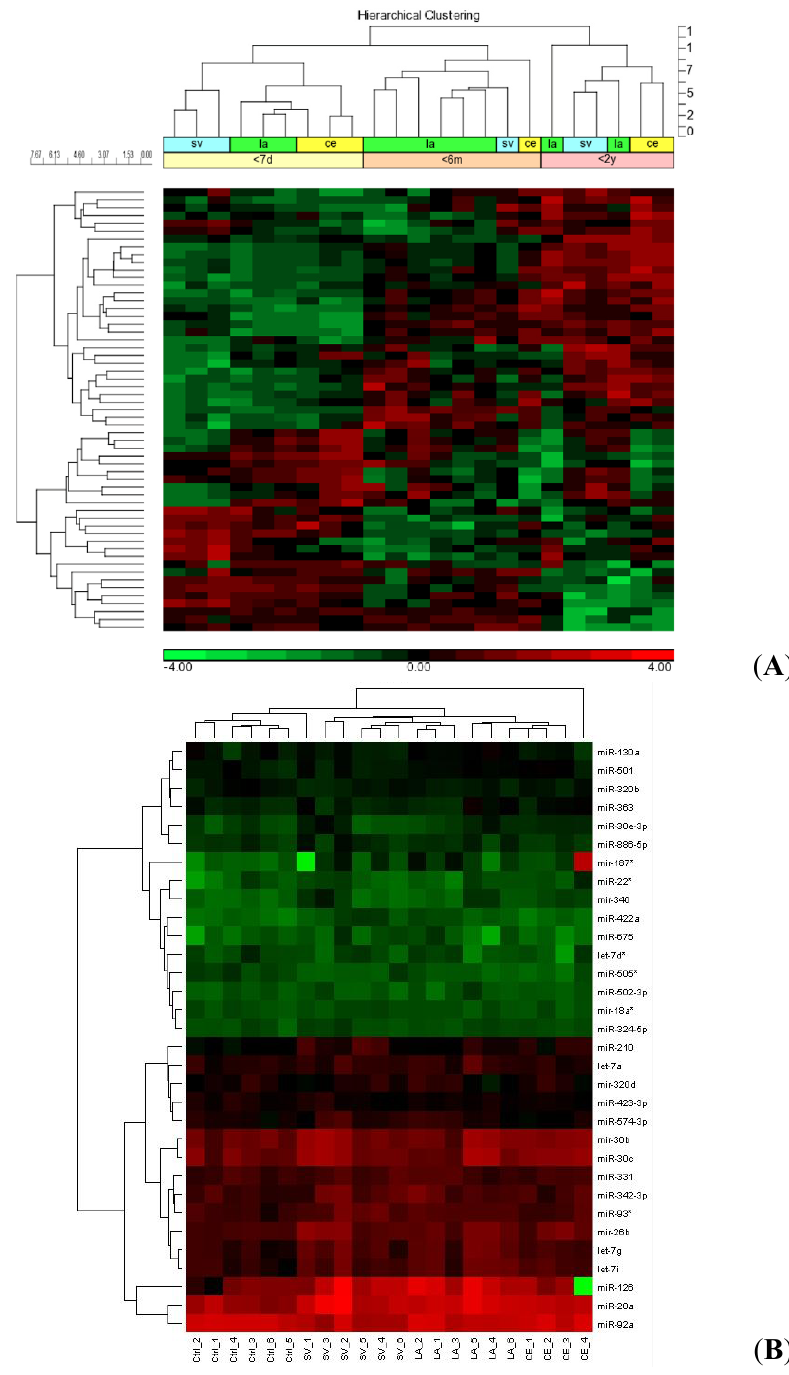
Figure 2. ( A ) Hierarchical clustering of miRNA profiles. Fifty seven (57) miRNAs were significantly expressed (FDR p value < 0.05) in various stroke etiologies. Hierarchical clustering identified these miRNAs as potential biomarkers of stroke etiology during the acute phase. Stroke subtypes: small vessel (SV), large artery (LA) and cardioembolic (CE). Time point from stroke onset: less than 7 days; less than 6 months; less than 2 years; and ( B ) validation of miRNA cluster. TLDA validation of the 57 miRNA cluster provided a more stringent panel of 32 miRNAs with C values of <32. Hierarchical clustering based T on the relative expression showed that the 32 miRNAs were able to segregate the patients according to their respective stroke